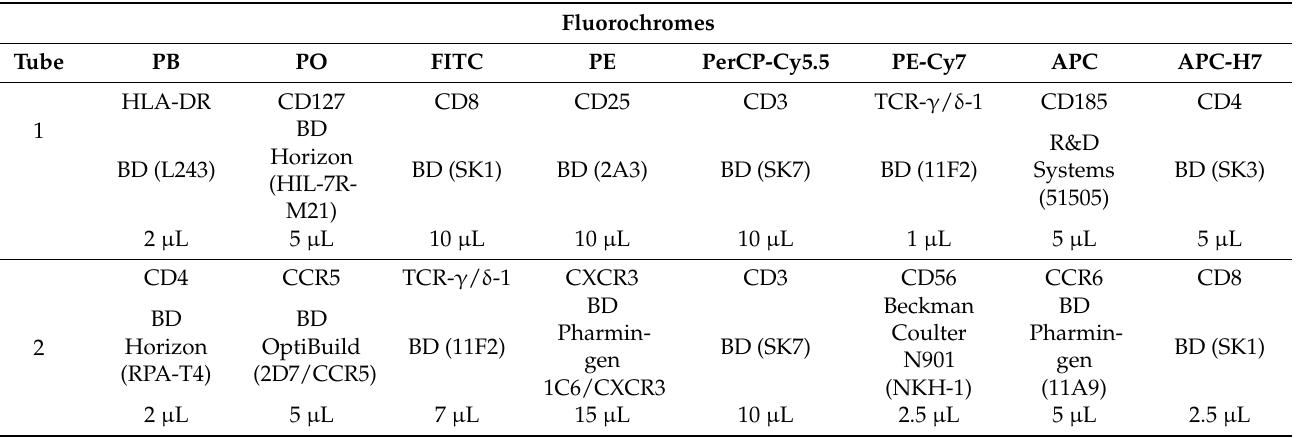
Table 2. The panel of monoclonal antibodies used for the T cells’ phenotypic characterization, indicating their respective volume, the fluorochrome, commercial source, and